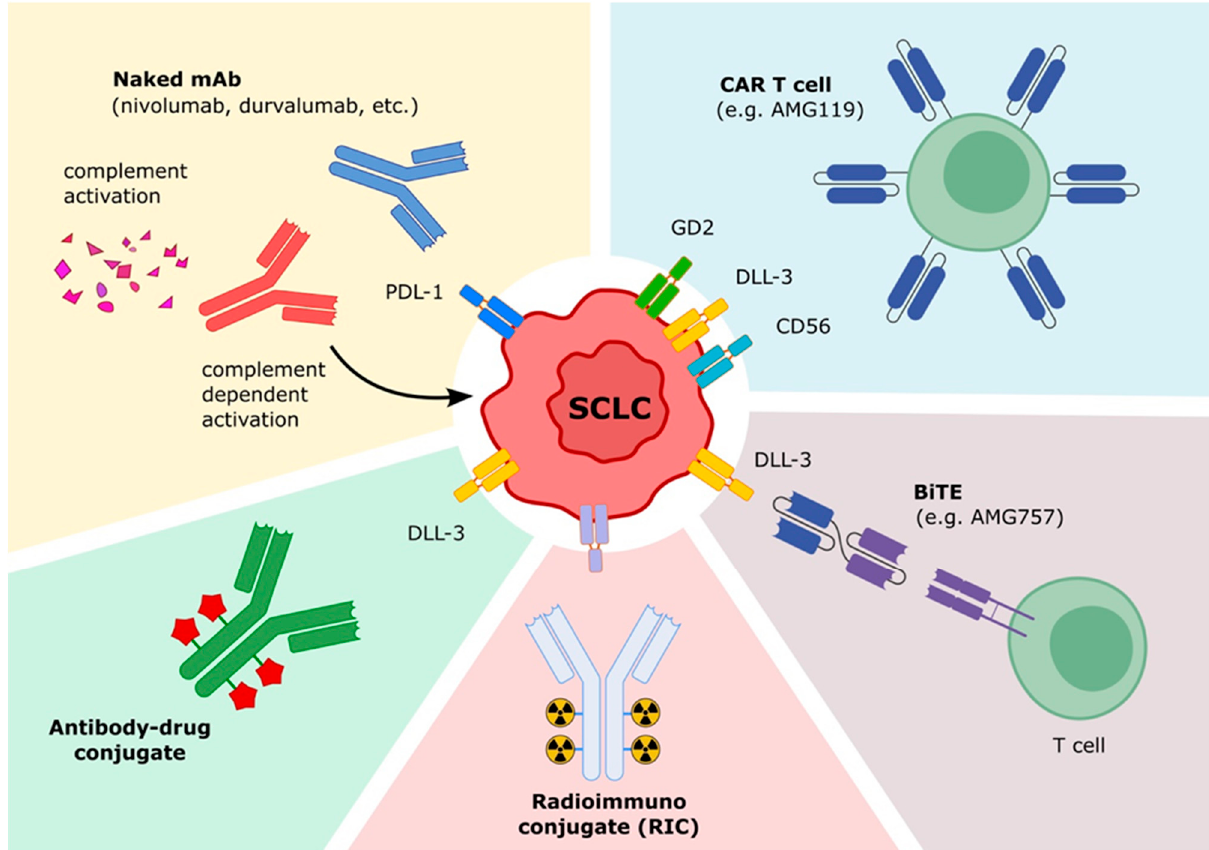
Figure 1. Novel immunotherapeutic strategies against SCLC. Naked mAbs act against SCLC with a different mechanism of action including the inhibition of the interaction between ligand and receptor, direct cytotoxicity of the antibody, induction of complement dependent cytotoxicity and by antibody-dependent cellular toxicity. CAR T cells. Genetically modified T cells are engineered to express a Chimeric Antigen Receptor to target a TAA. The binding of the CAR with the antigen triggers the activation of the CAR T cell which releases perforin, granzyme and other cytokines with a cytotoxic effect. Bispecific T cell Engager (BiTE). BiTEs are composed by two ScFV moiety bound together. One recognized the TAA and the other one identified the CD3 of the T cell to steer the immune response directly to SCLC. Radioimmunoconjugate (RIC). RICs are antibodies linked to a radioactive substance that might be exploited to treat SCLC, taking advantage of the specificity of a mAb and the cytotoxic effect of a radioactive compound. Antibody-Drug conjugate (ADC). ADCs are cytotoxic molecules or proteins bound to an antibody directed against a TAA (e.g., Rova-T) to more efficiently target the tumor.